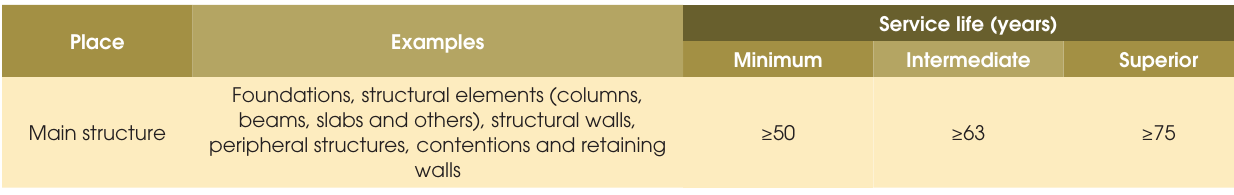
Table 1 – Service life for minimum, intermediate and superior levels for residential structures Place